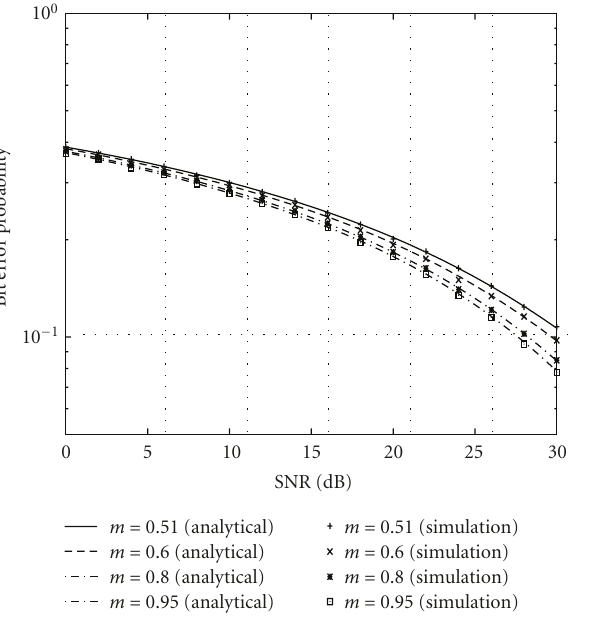
Figure 6: BEP for 256-PAM subject to Nakagami- m fading for di ff erent values of m .